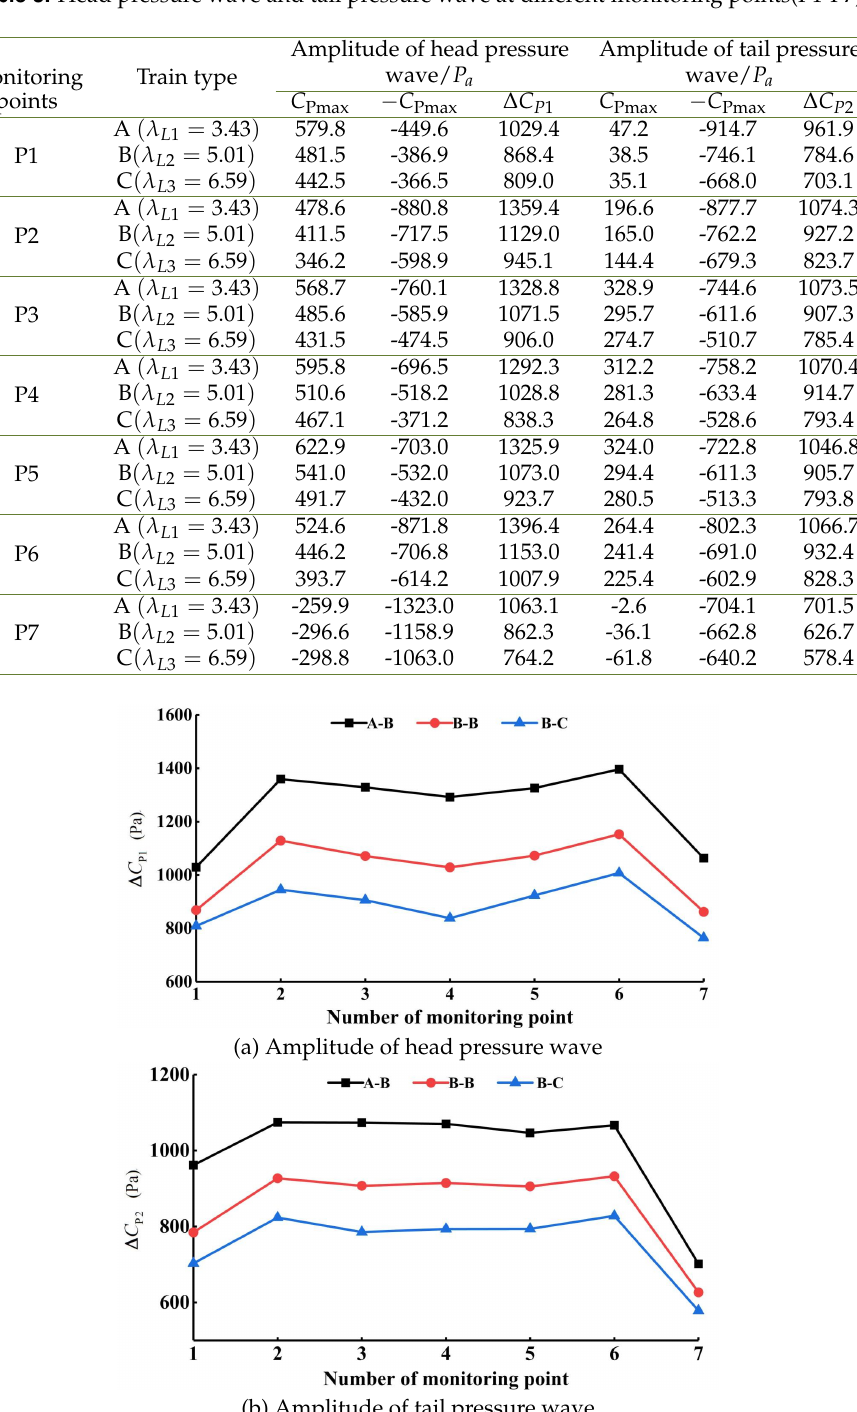
Table 3. Head pressure wave and tail pressure wave at different monitoring points(P1-P7)